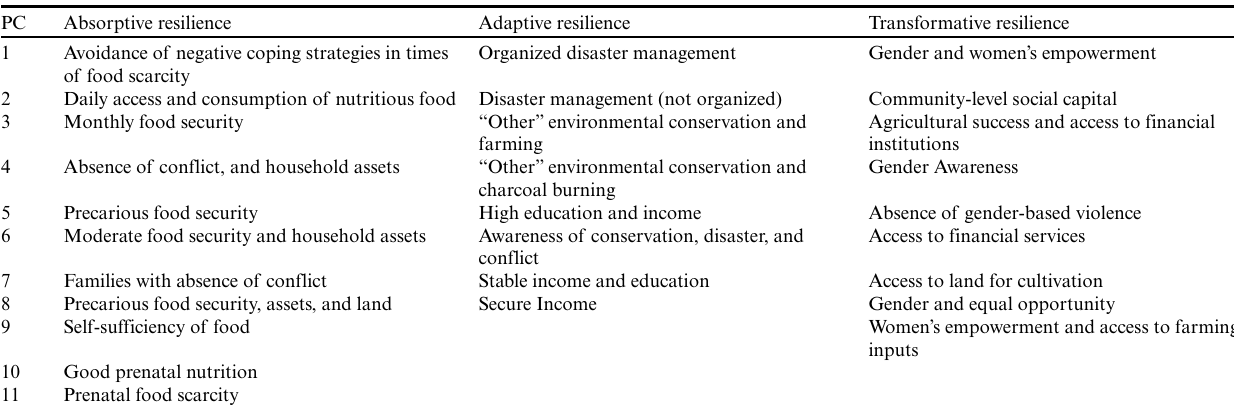
Table 7 . Principal components (PC) retained in the absorptive, adaptive, and transformative resilience categories. PC